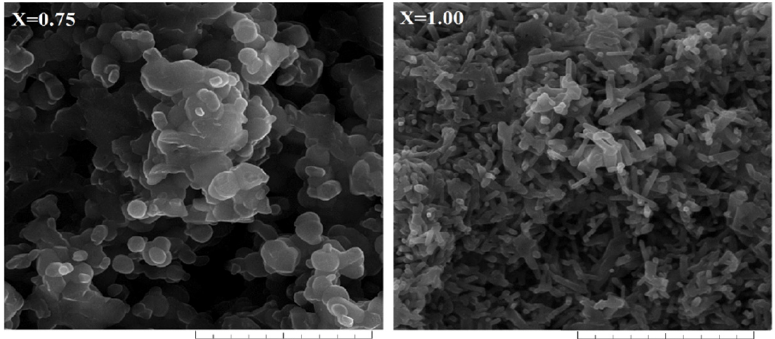
Figure 3. SEM micrographs of Al 1-x Sb x FeO 3 perovskites.